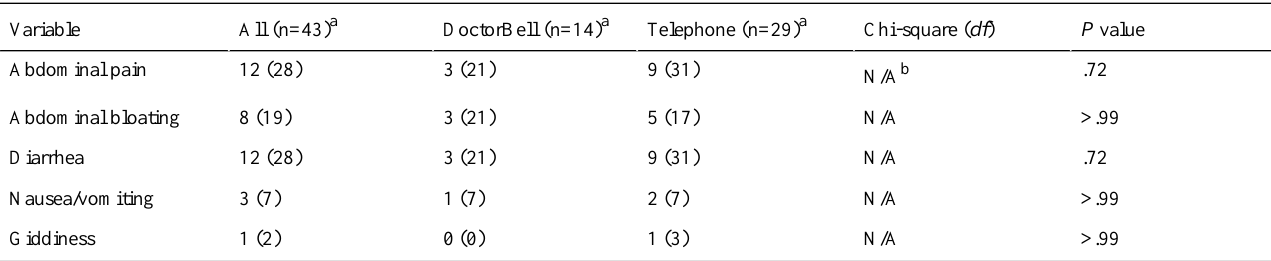
Table 3. Patient symptoms on follow-up teleconsultation reported in a web-based survey via a link provided following patient